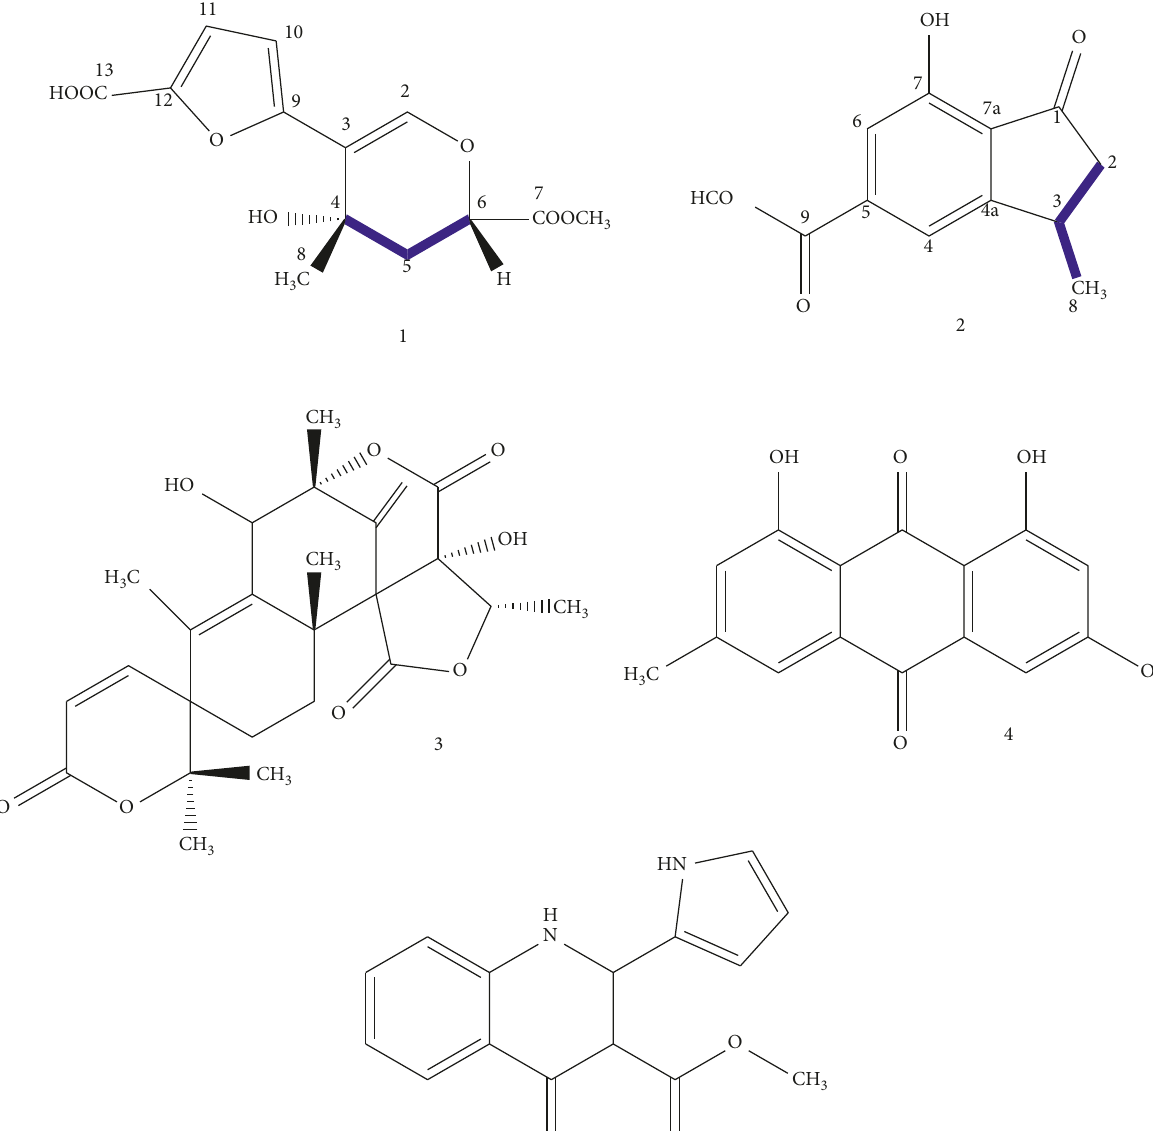
Figure 1: Structures of compounds 1 – 5 and key 1 H- 1 H COSY ( ) correlations of 1 and 2